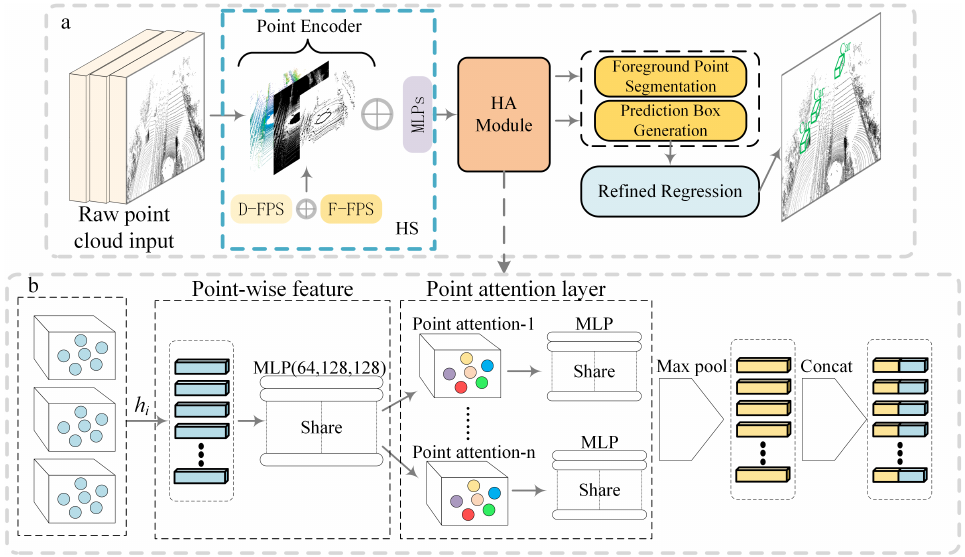
Figure 2. HA-RCNN model frame diagram ( a : Overall frame, b : HA module